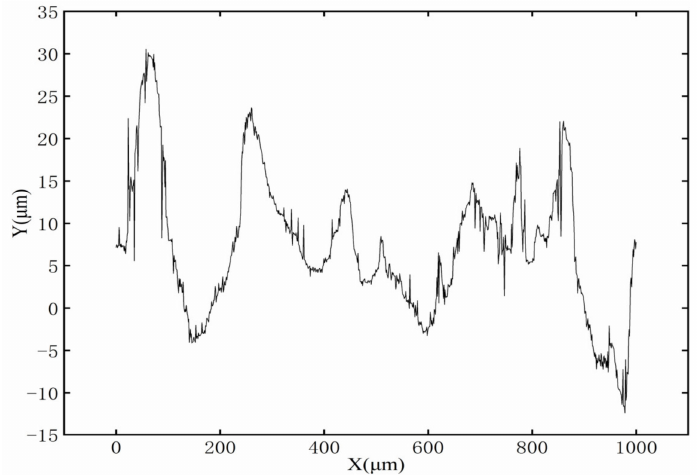
Figure 7. Initial surface